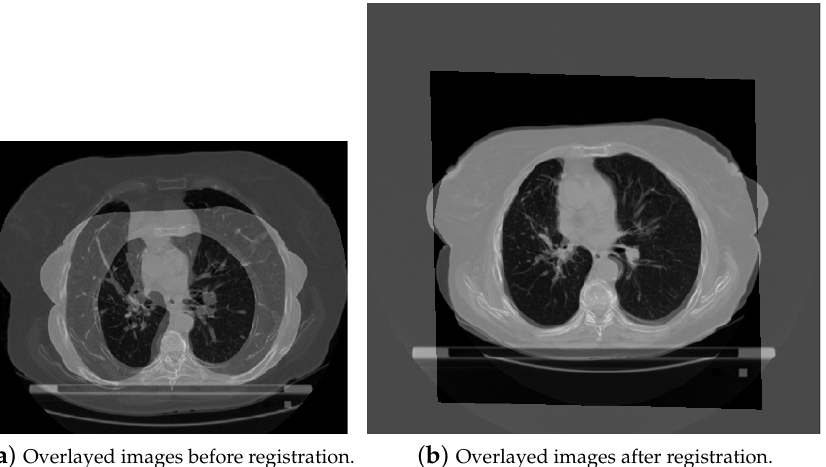
Figure 17. Illustration of the affine 3D registration with raw input slices.